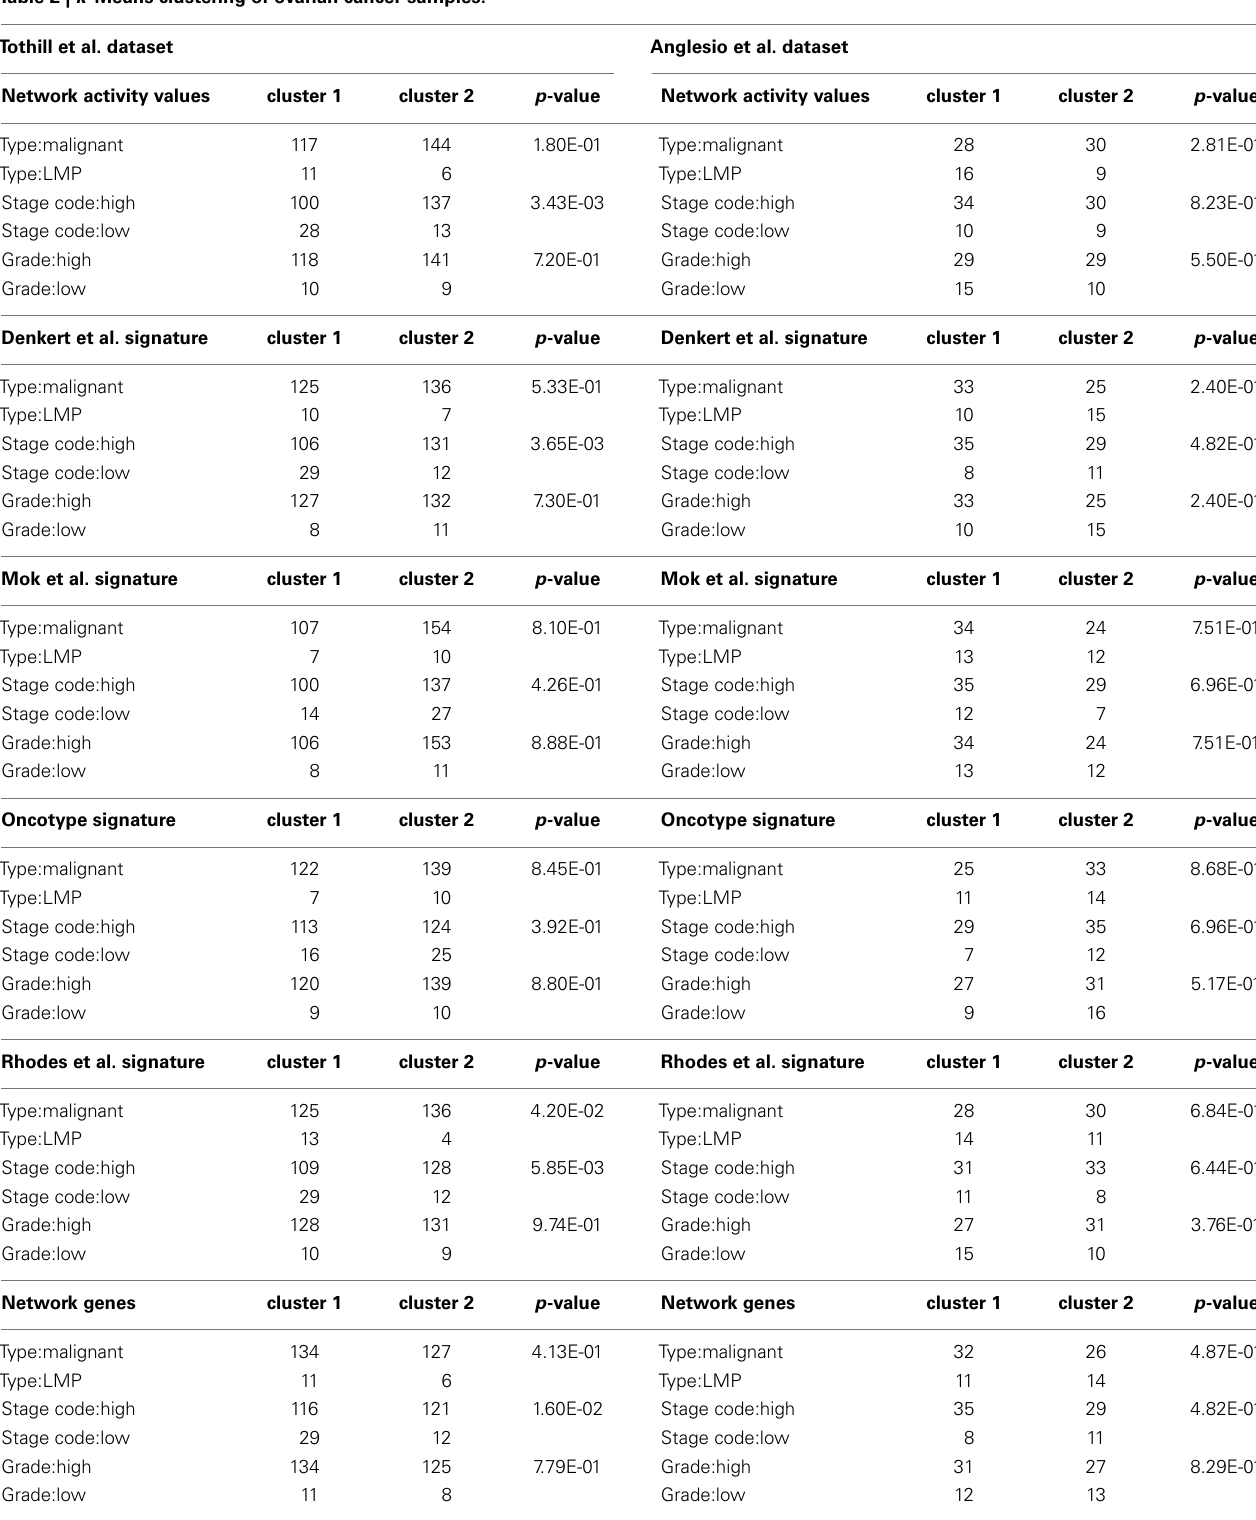
Table 2 | k -Means clustering of ovarian cancer